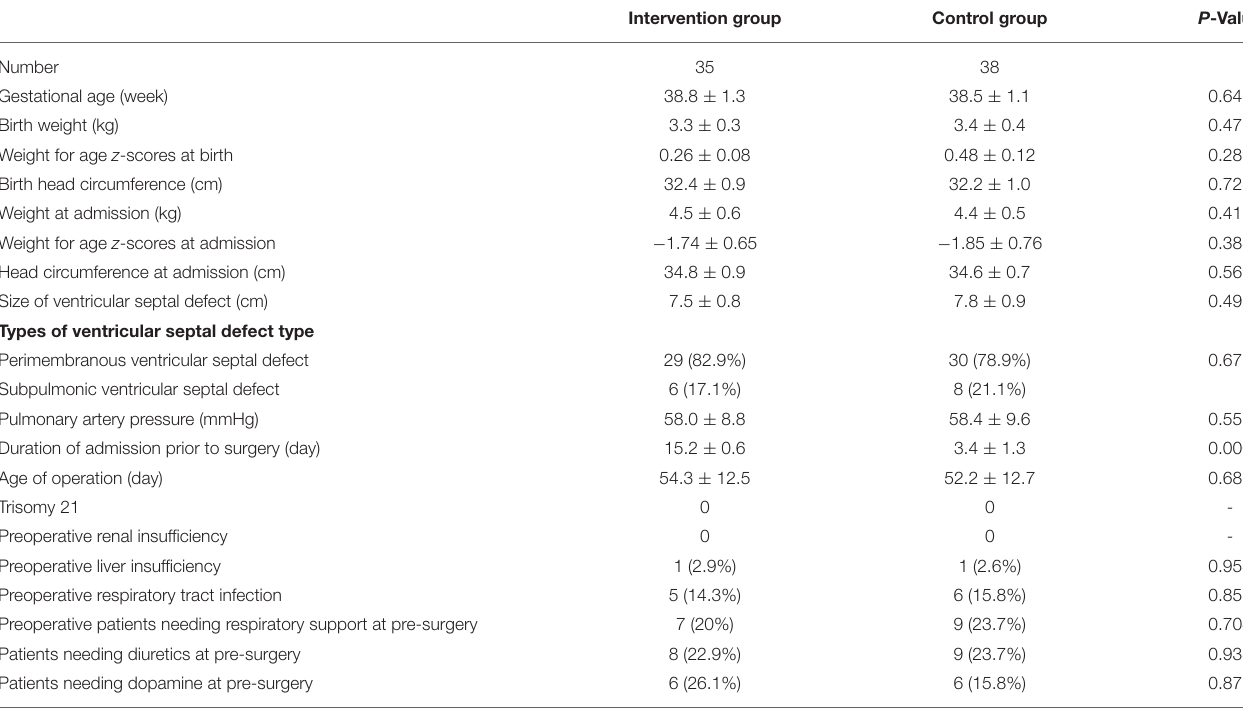
TABLE 1 | Comparison of the demographic data between the two groups [mean ± SD or (%)].